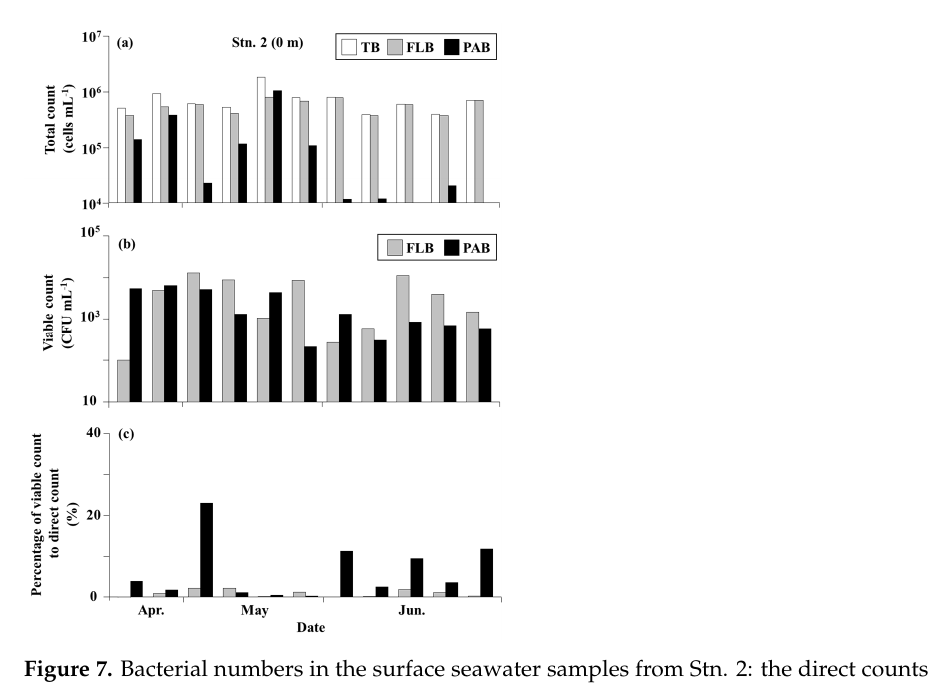
Figure 7. Bacterial numbers in the surface seawater samples from Stn. 2: the direct counts ( a ), the viable counts (CFU) ( b ), and the percentages of viable counts to direct counts ( c ).